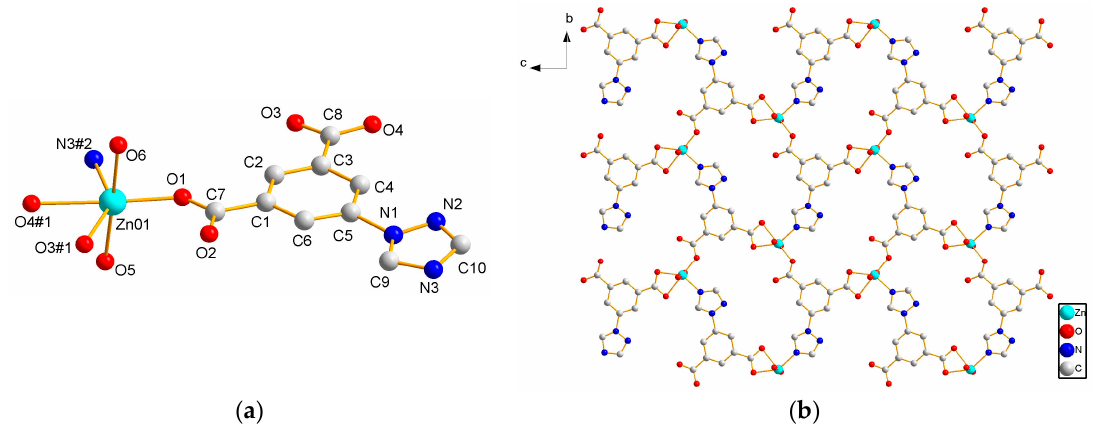
Figure 2. ( a ) Coordination environment of Zn(II) ion in 2 . ( b ) The 2D layer of 2 .